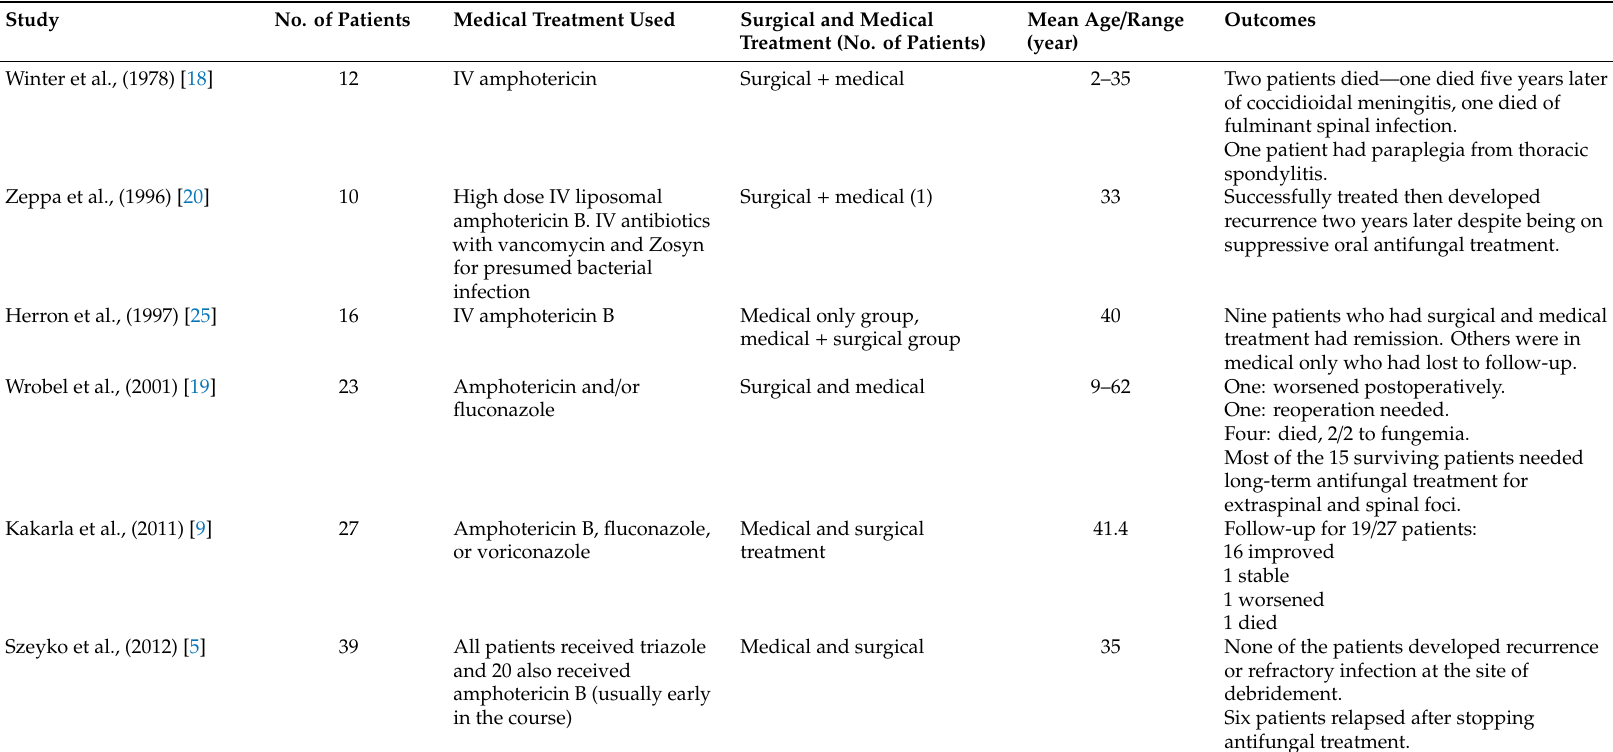
Table 1. Summary of case reports of coccidioidomycotic